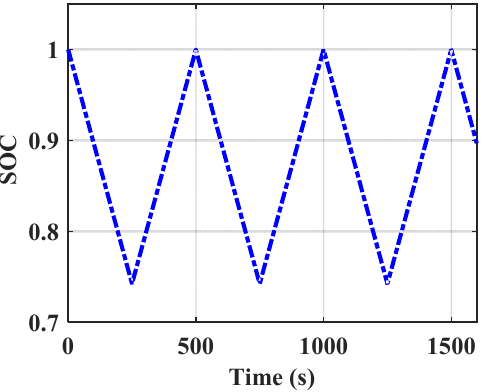
Figure 7. Change in state of charge (SOC) of ultracapacitor (UC) during charging/discharging.